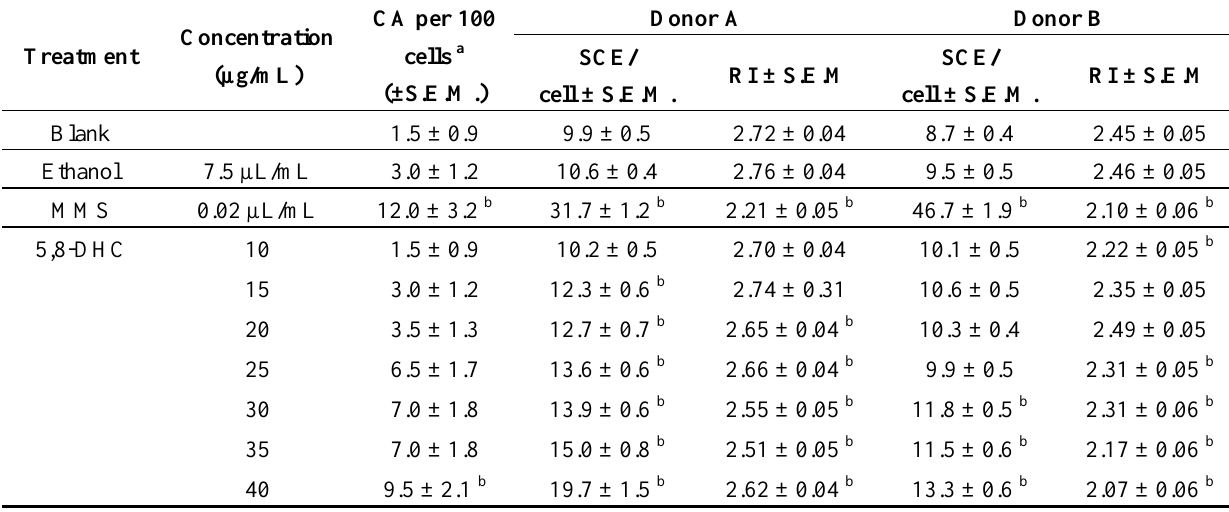
Table 2. Effects of 5,8-dihydroxycoumarin (5,8-DHC) on the frequency of chromosome aberrations (CAs), sister chromatid exchanges (SCEs) and replication index (RI) values in human lymphocyte cultures in